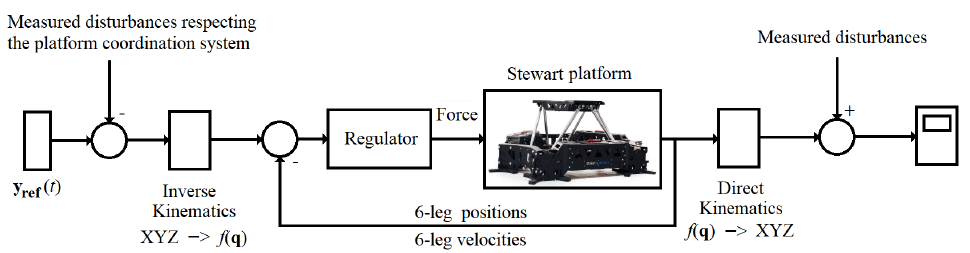
Figure 9. Stewart platform stabilization system [Source: MovieBird Intl.].